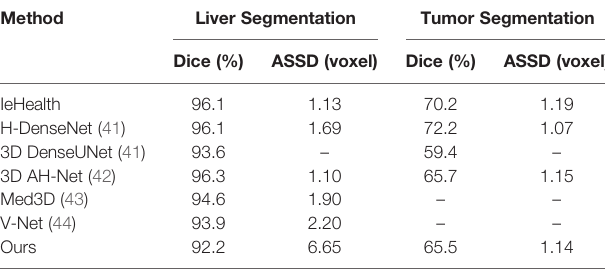
TABLE 4 | Automatic segmentation results of different methods in LiTS challenge.